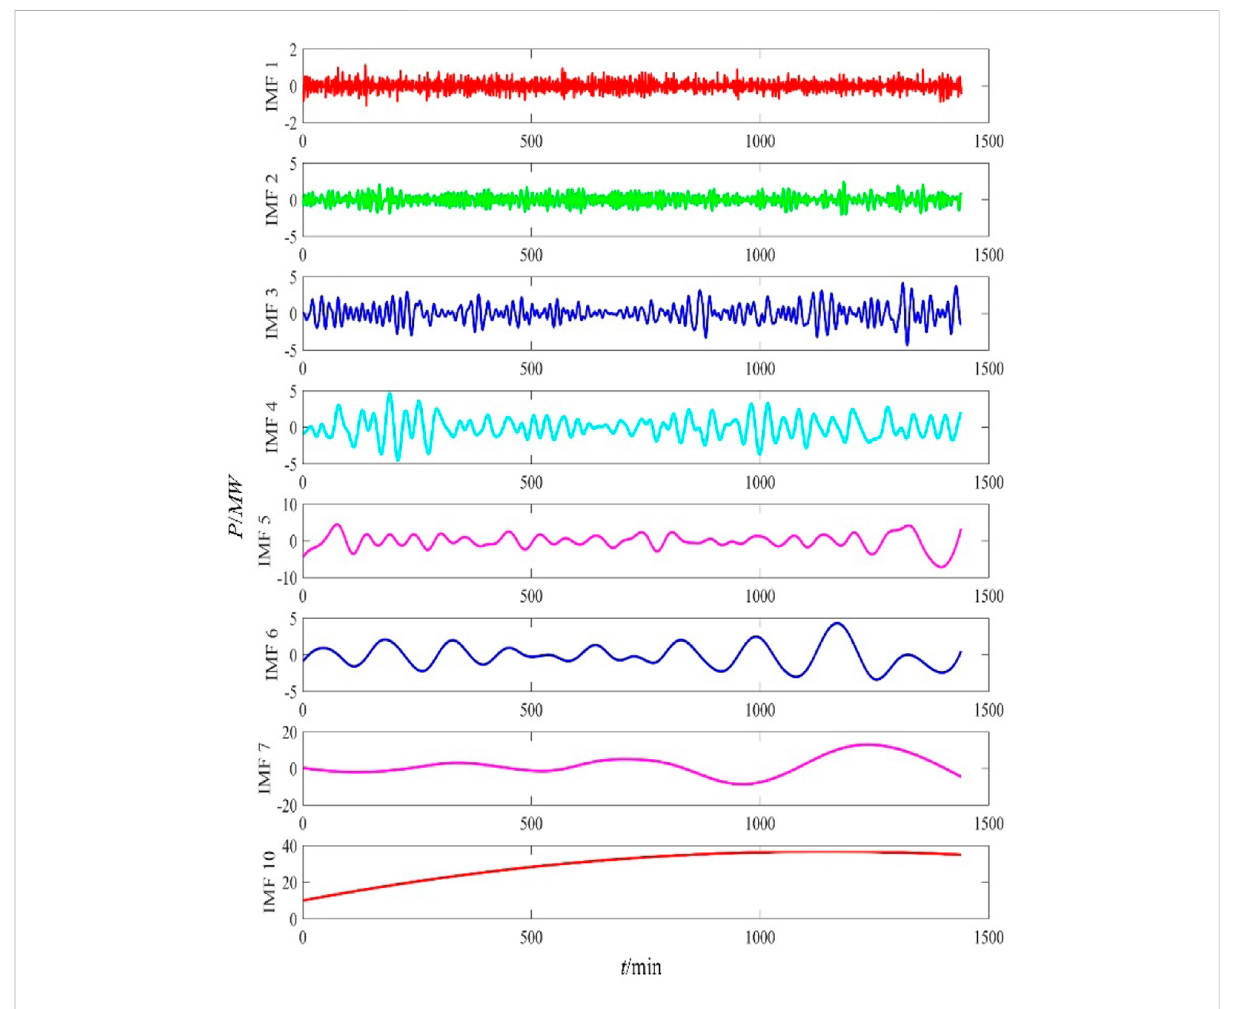
FIGURE 4 Decomposition of raw wind power by